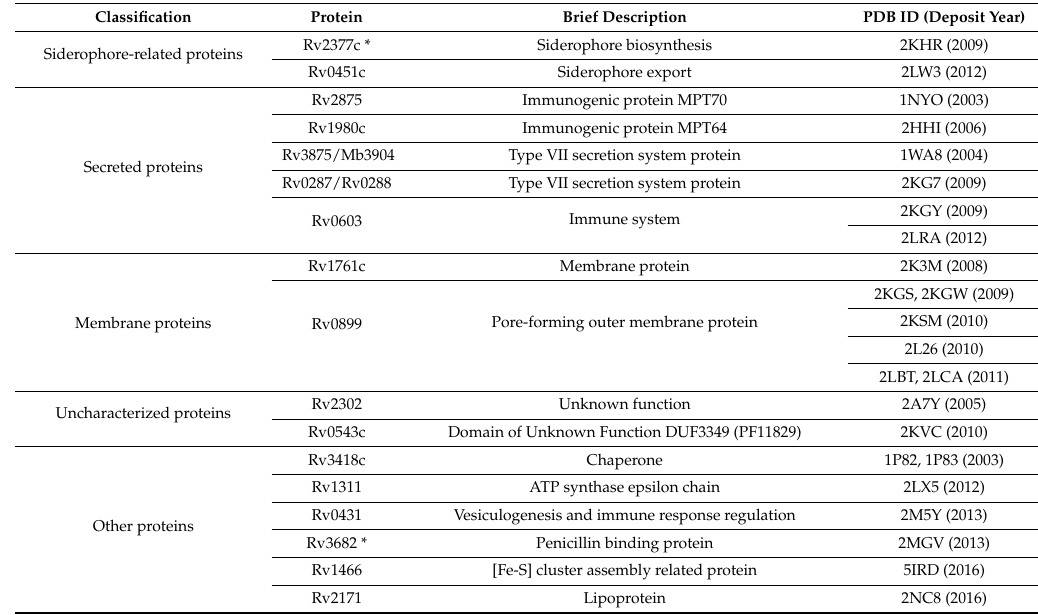
Table 1. Overview of NMR structures from M . tuberculosis proteins.